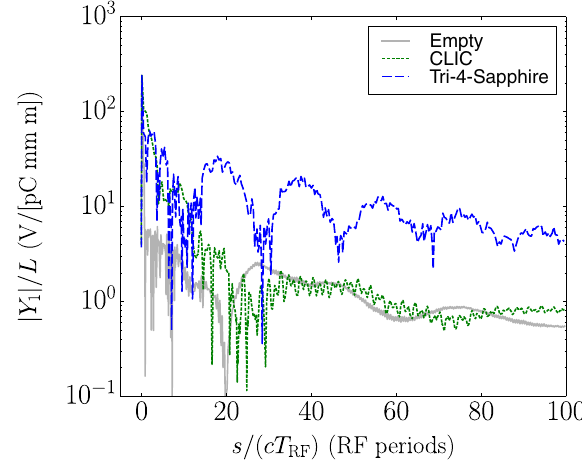
FIG. 5. Oscillations in the envelope of the monopole wake potential indicate the presence of monopole HOMs. The rf period ¼ ð 12 GHz Þ − 1 ¼ 83 . 3 ps. is T rf